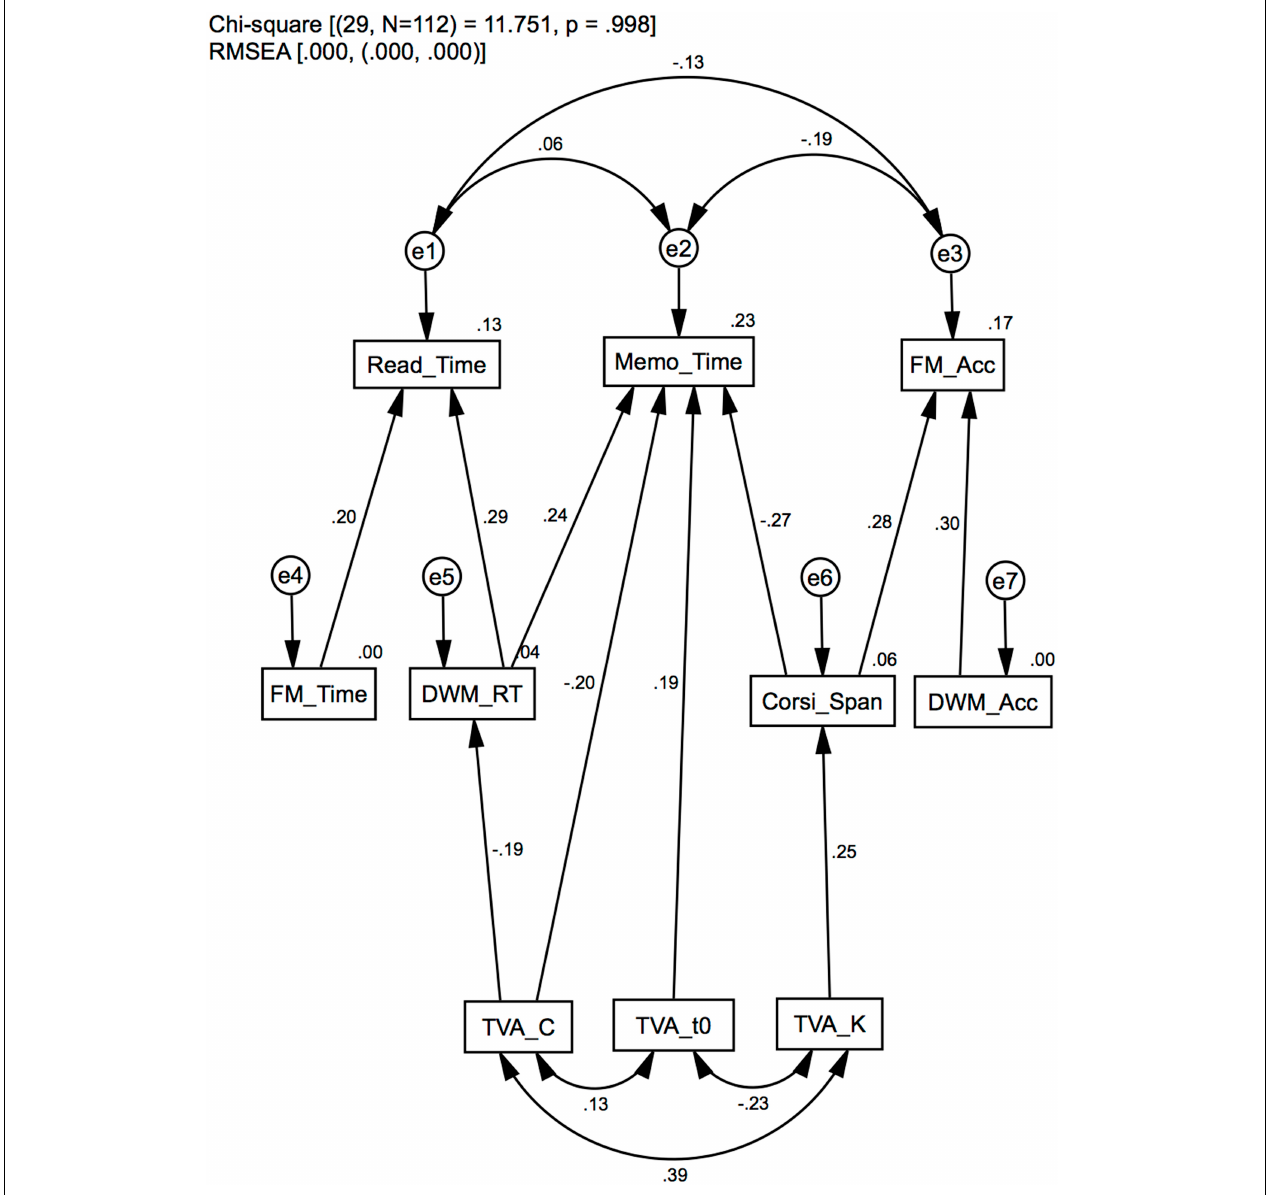
FIGURE 1 | Model 1: Standardized path analysis. Hierarchical dependencies in layers according to functional complexity, and in distinct structures according to functional specificity: processing speed (left), VSTM